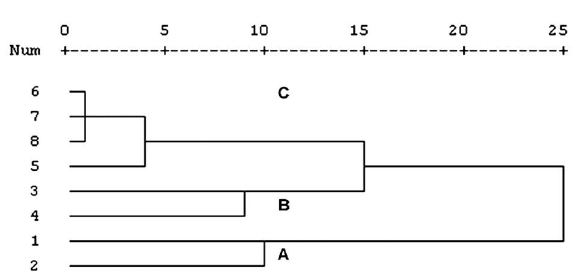
Fig . 1. – Dendrogram of dissimilarity between the parasite fauna of different groups (depending on location and size host) of Mullus barbatus and Citharus linguatula . 1, size 1 Blanes individuals of Mullus barbatus ; 2, size 2 Blanes individuals of Mullus barbatus ; 3, size 1 Barcelona individuals of Mullus barbatus ; 4, size 2 Barce- lona individuals of Mullus barbatus ; 5, size 1 Blanes individuals